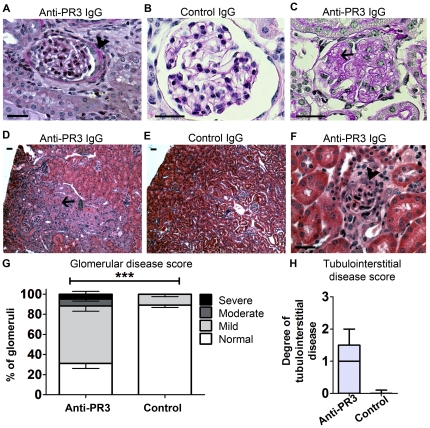
Anti-PR3 antibodies cause kidney disease.(A–C) PAS stained images of glomeruli from chimera mice 6 days after injection with anti-PR3 (n = 18, A, 400×; C, 600×) or control IgG (n = 8, B, 600×). Note extra-capillary proliferation and peri-glomerular inflammation (arrowhead) (A), and mesangiolysis (C, arrow) in anti-PR3 treated mice. (D–F) H & E stained sections of kidney from chimera mice treated with anti-PR3 (D, 40×) or disease control (E, 40×) IgG. There are regions of tubulointerstitial injury, with red cell cast formation (arrow). (F) Demonstrates intense peri-glomerular inflammation in an animal treated with anti-PR3 IgG (arrowhead, 400×). By comparison mice treated with disease control IgG showed minimal glomerular or tubulointerstitial changes. (G) Fractions of glomeruli affected in anti-PR3 (n = 18) and control IgG (n = 8) treated animals (Error bars depict SEM; ***p = 0.001) (H). Degree of tubulointerstitial disease in mice treated with anti-PR3 antibodies and control antibodies (*P<0.05, median ± IQ ± max/min values). (Bars = 50 µm).